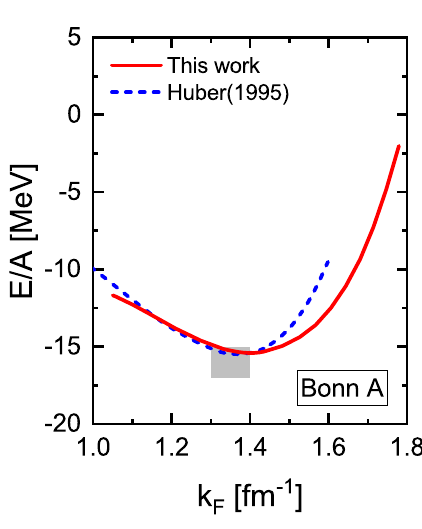
Figure 1. Binding energy per nucleon E / A in symmetric nu- clear matter as a function of the Fermi momentum k F . Treatment with NESs (red) is compared with an approximate treatment of Ref. [48](dashed blue).